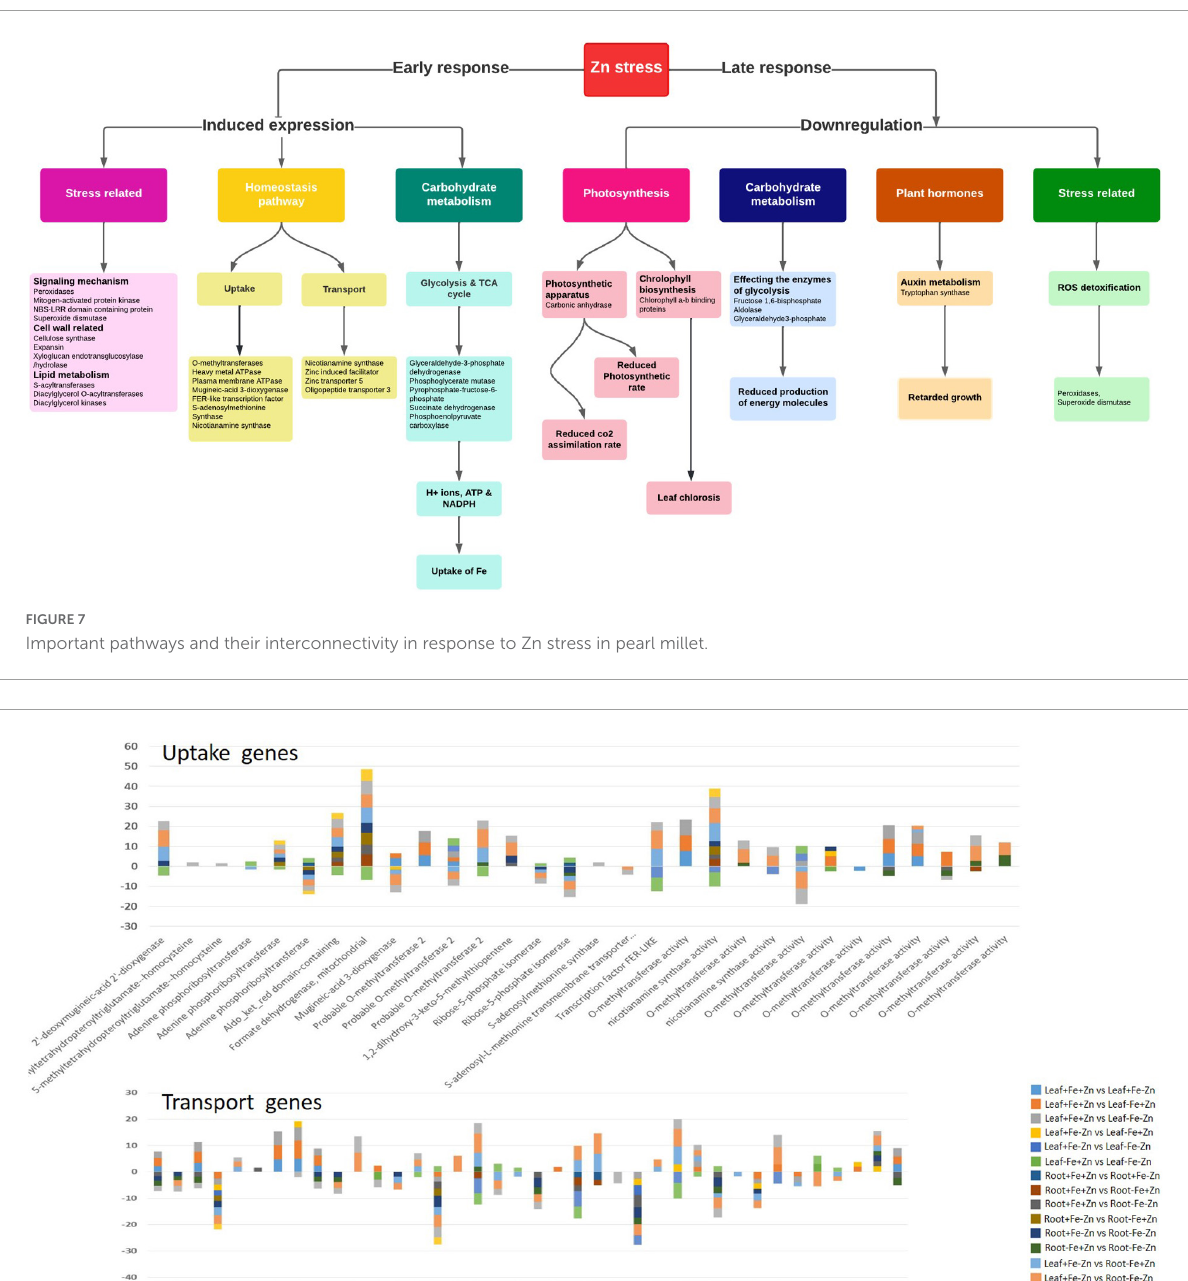
are the vacuolar membrane transporters that aid in Zn tolerance during excess accumulation of Zn in Fe-deficient